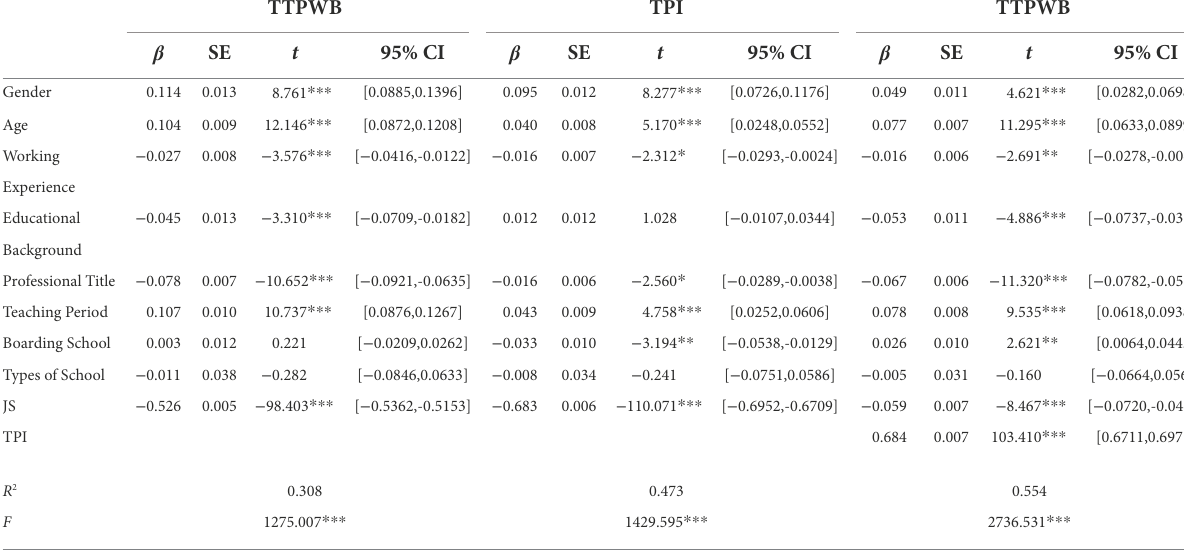
TABLE 2 Testing the mediation effect of teachers’ professional identity between job-related stress and teachers’ professional well-being.